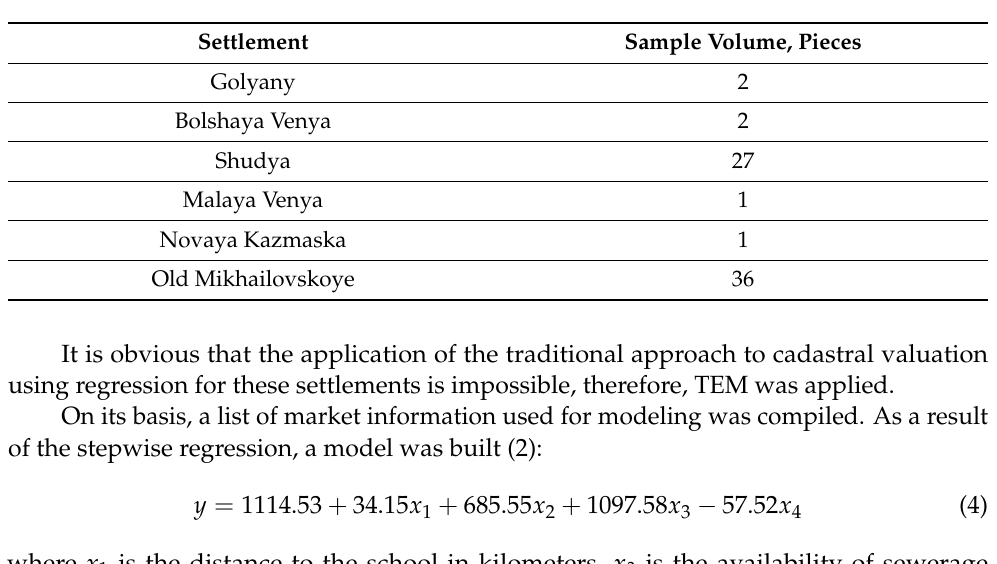
Table 7. The amount of market